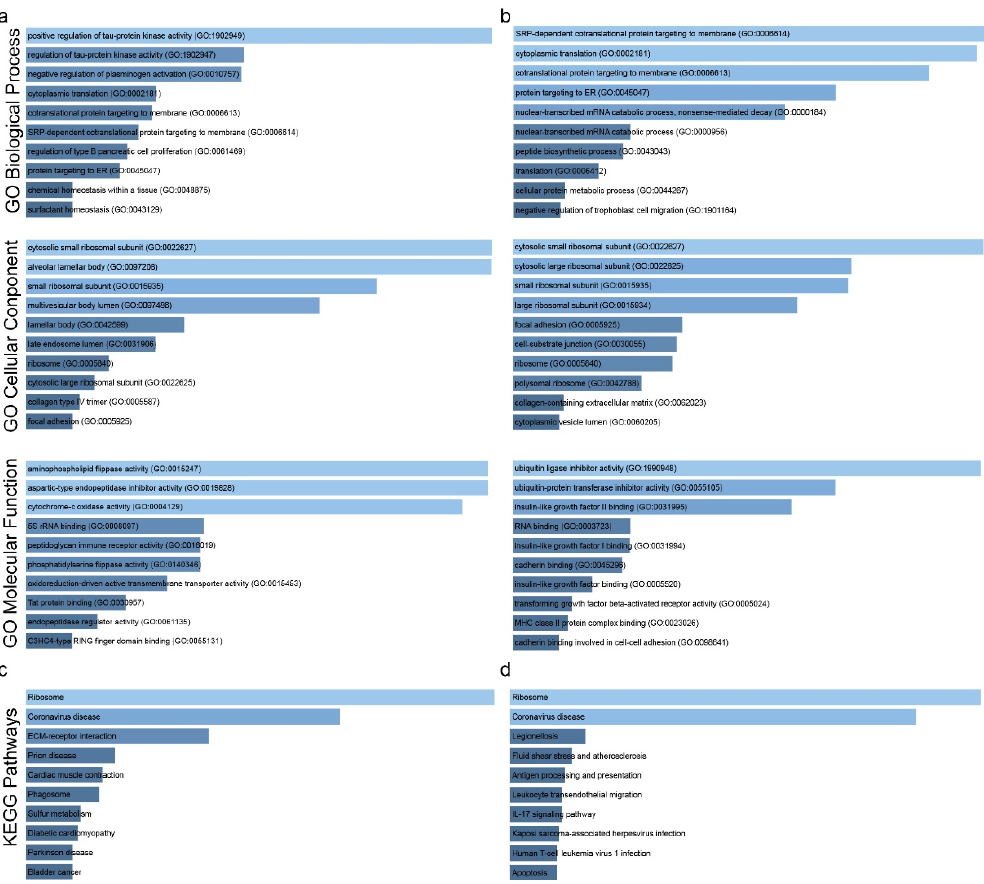
Figure 5. Gene Ontology (GO) enrichment analysis of the co-DEGs in single-gene perturbation experiments in lung cancer. ( a ) GO enrichment results of the co-upregulated genes in lung cancer against the normal tissue. ( b ) GO enrichment results of the co-downregulated genes in lung cancer against the normal tissue. KEGG enrichment analysis regarding the co-DEGs in single-gene pertur- bation experiments in lung cancer. ( c ) KEGG enrichment for the co-upregulated genes and ( d ) the co-downregulated genes. Bar graphs were sorted using a combined score between the Benjamini– Hochberg (BH)-adjusted p -value and the z-score of the deviation from the expected rank. Each bar’s length shows the significance of the corresponding term being relative to the color brightness of each